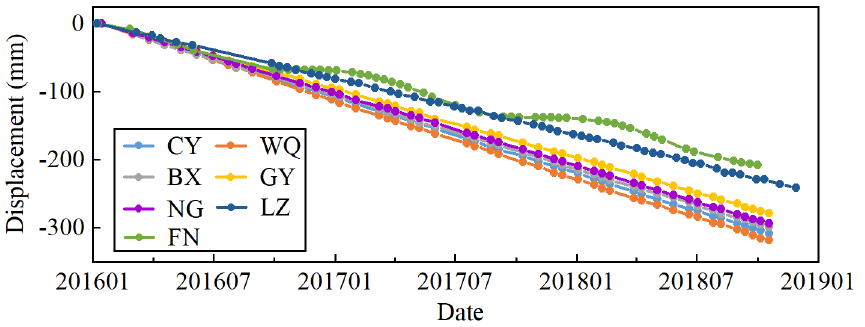
Figure 4. Accumulative time-series deformation revealed by the interferometric synthetic aperture radar (InSAR) technique: the locations of the selected points are marked by black rhombus symbols in Figure 2a.